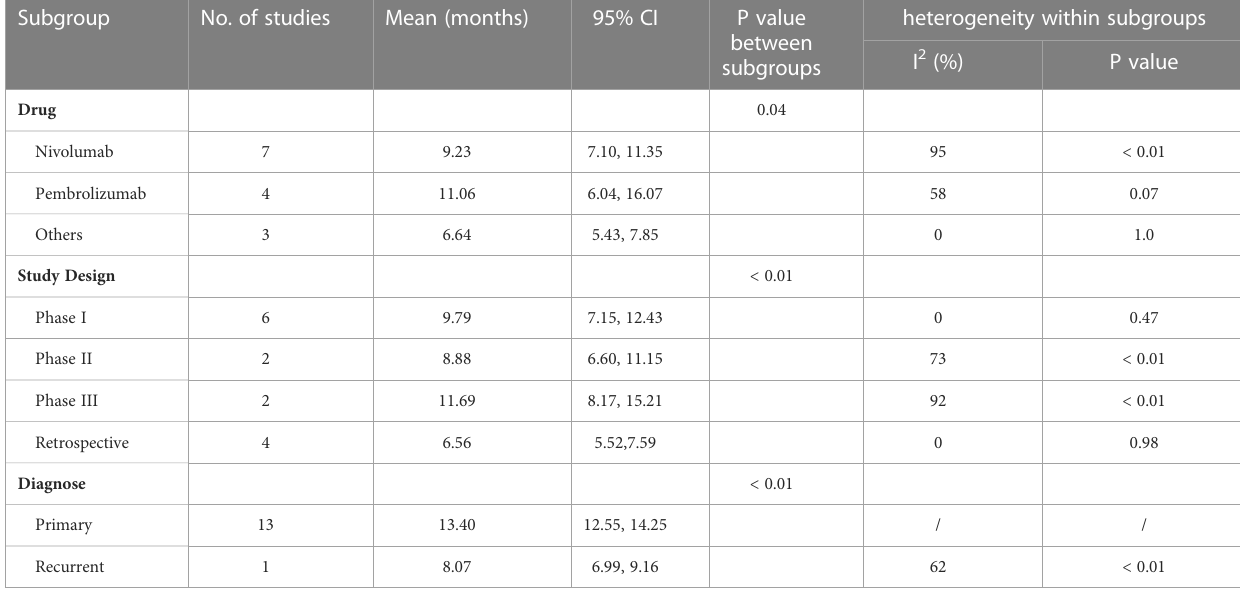
TABLE 2 Subgroup analysis of pooled estimates of the median overall survival.